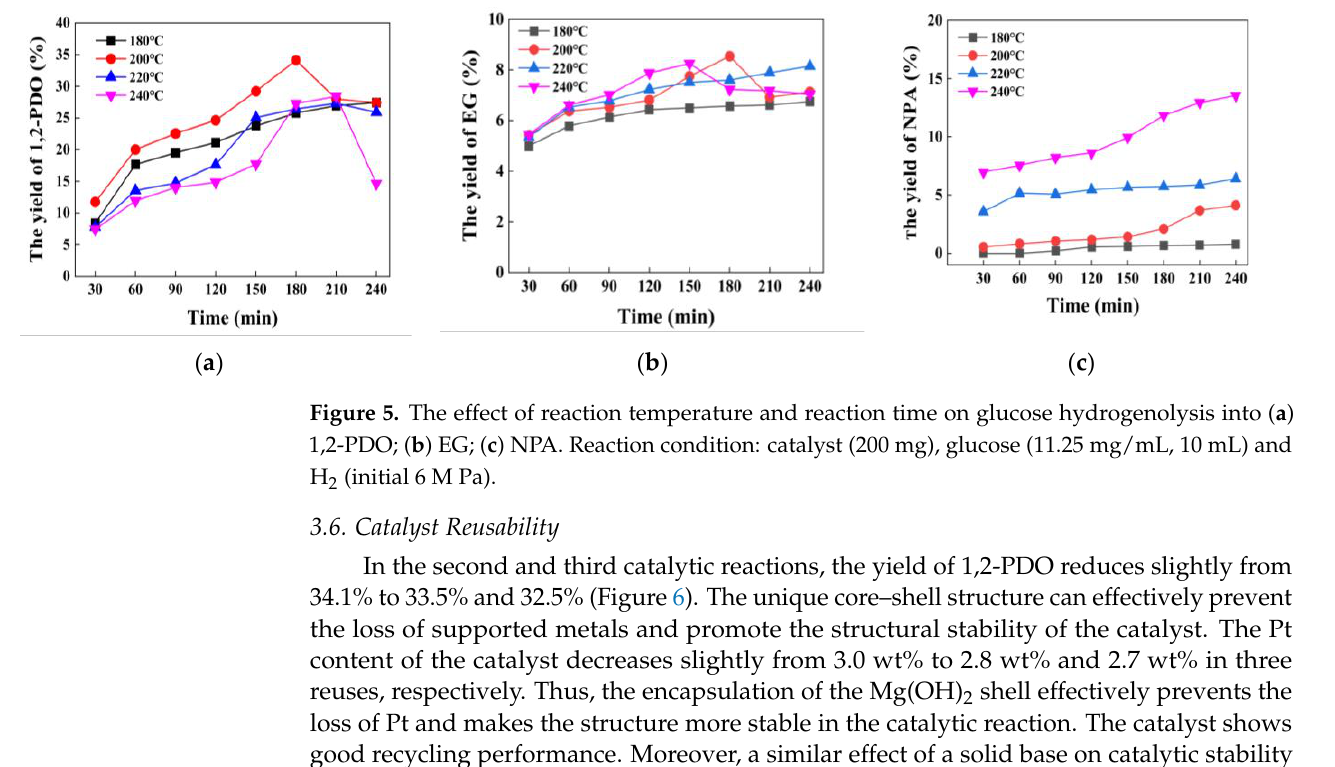
Figure 5. The effect of reaction temperature and reaction time on glucose hydrogenolysis into ( a ) 1,2-PDO; ( b ) EG; ( c ) NPA. Reaction condition: catalyst (200 mg), glucose (11.25 mg/mL, 10 mL) and H 2 (initial 6 M Pa).